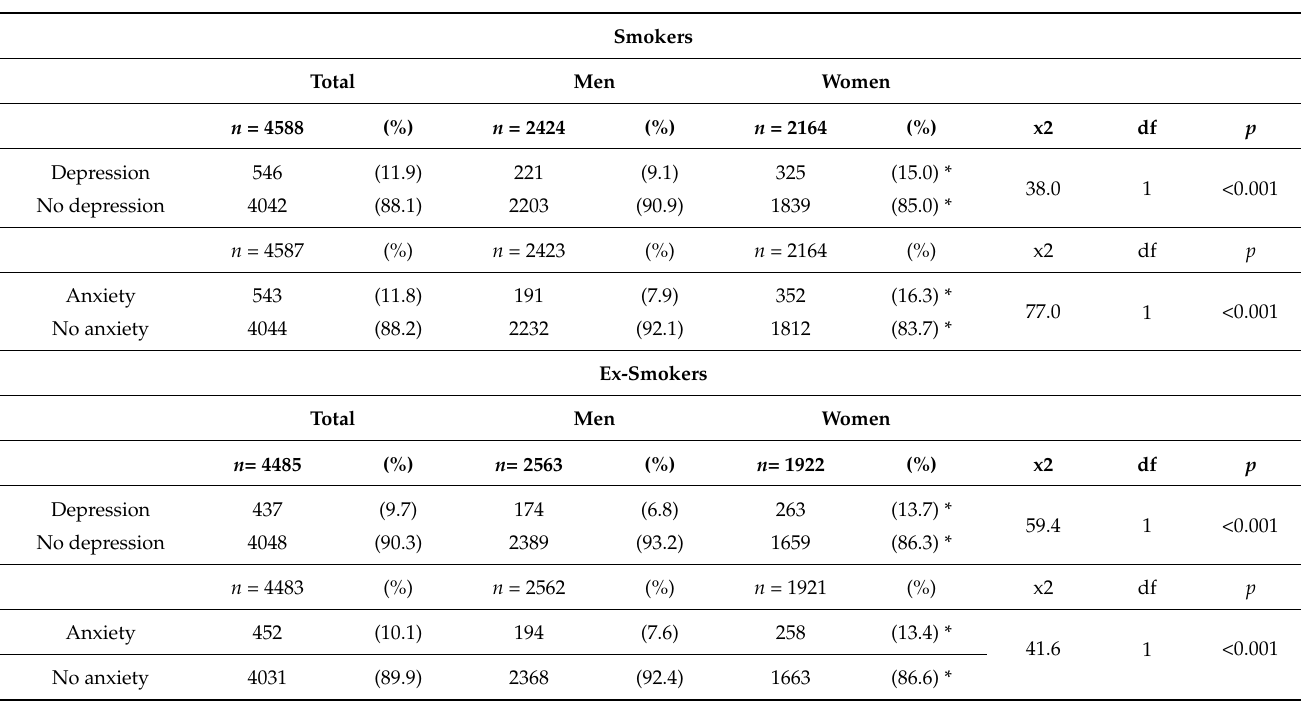
Table A5. Prevalence of depression and anxiety in Spanish smokers and ex-smokers, and comparison by sex: